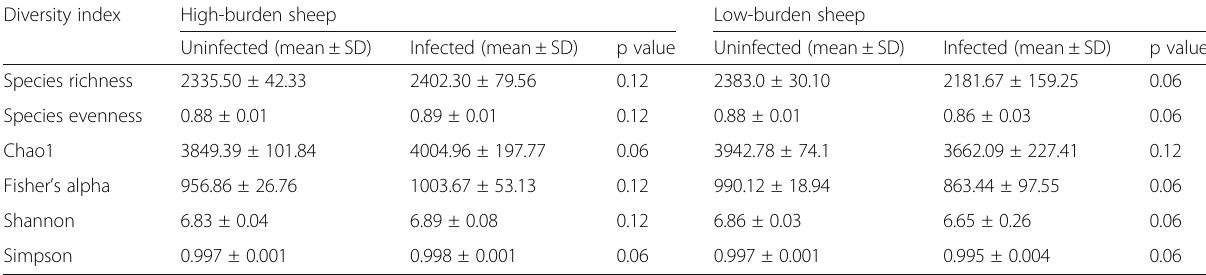
Table 2 Microbial diversity indices of the faecal microbiota of uninfected and infected sheep Diversity